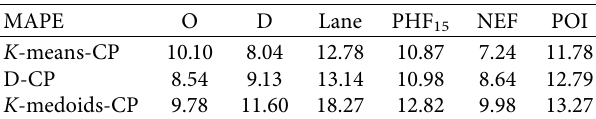
Table 4: The accuracy comparison in single variable influence degree